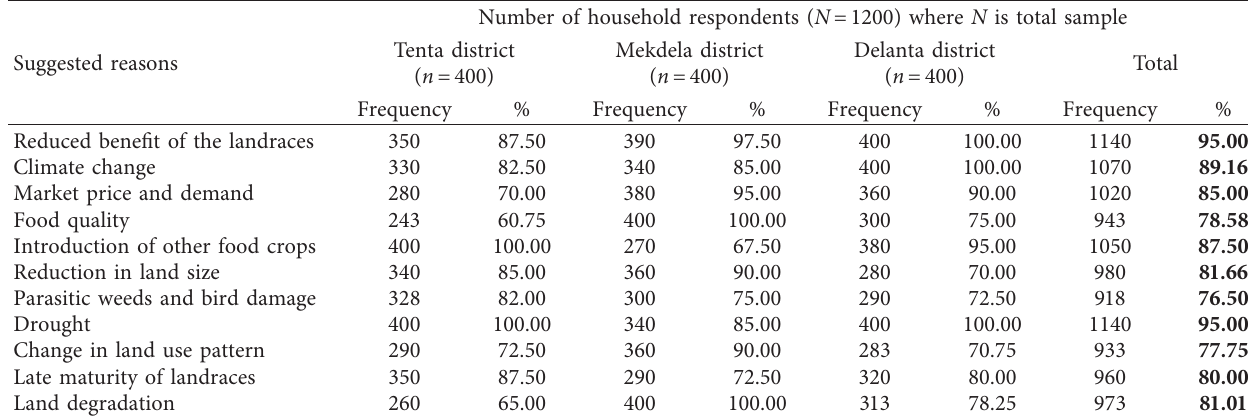
Table 5: Frequency and proportions of farmers citing different reasons for replacement of sorghum landraces in three districts. Suggested